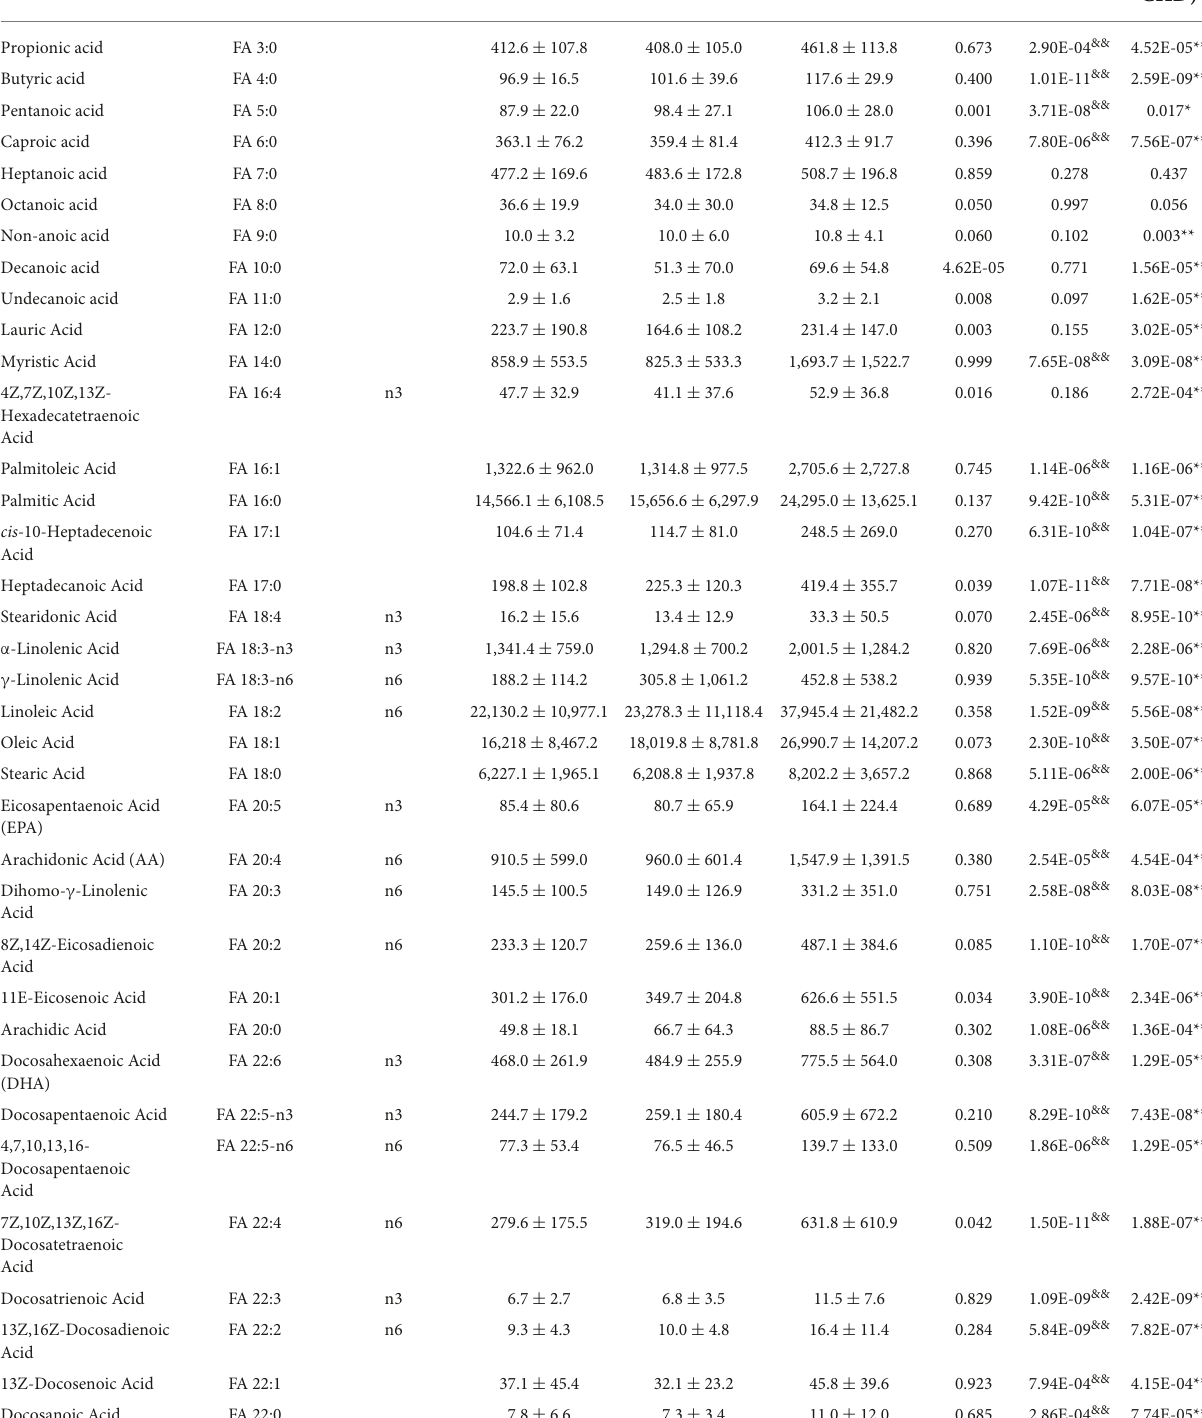
TABLE 3 FA concentrations (mean ± SD) in different